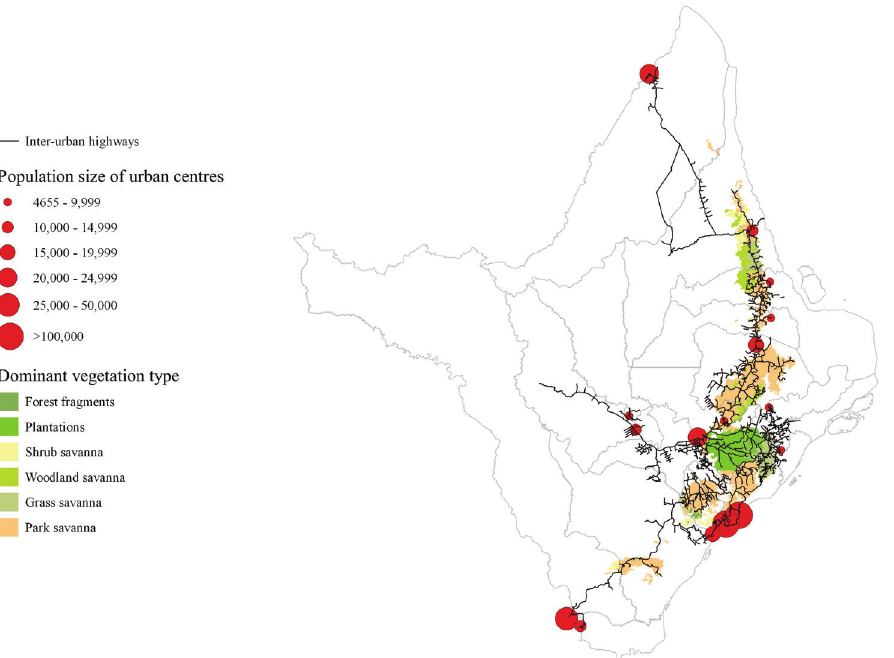
Figure 3. Highways and conurbations in the Cerrado of Amapá. The network of main highways (black lines), and municipal limits (grey lines) in the state of Amapá obtained from the Amapá State Environ- mental Secretariat (SEMA-AP 2016). The total length of highways in the state is 3,578.5 km, of which 1,999.9 km (55.9%) is within the Cerrado of Amapá. Of the 16 urban centres, 11 are within 10 km of the Cerrado of Amapá (points, with the size of the point proportional to the population – information obtained from IBGE